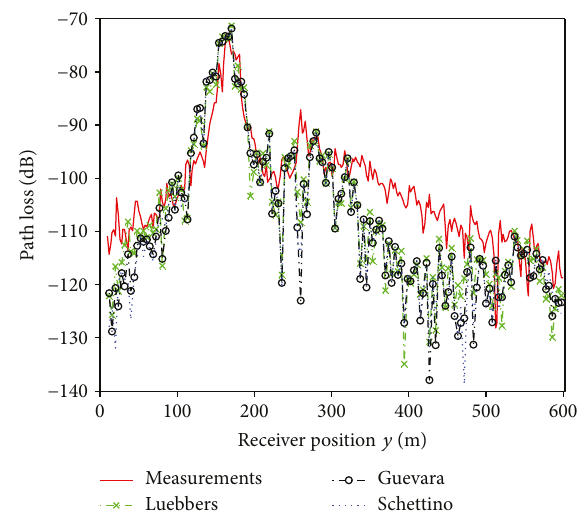
Figure 15: Path loss comparison between the heuristic UTD coe ffi cients and data (red line) for Bank St.